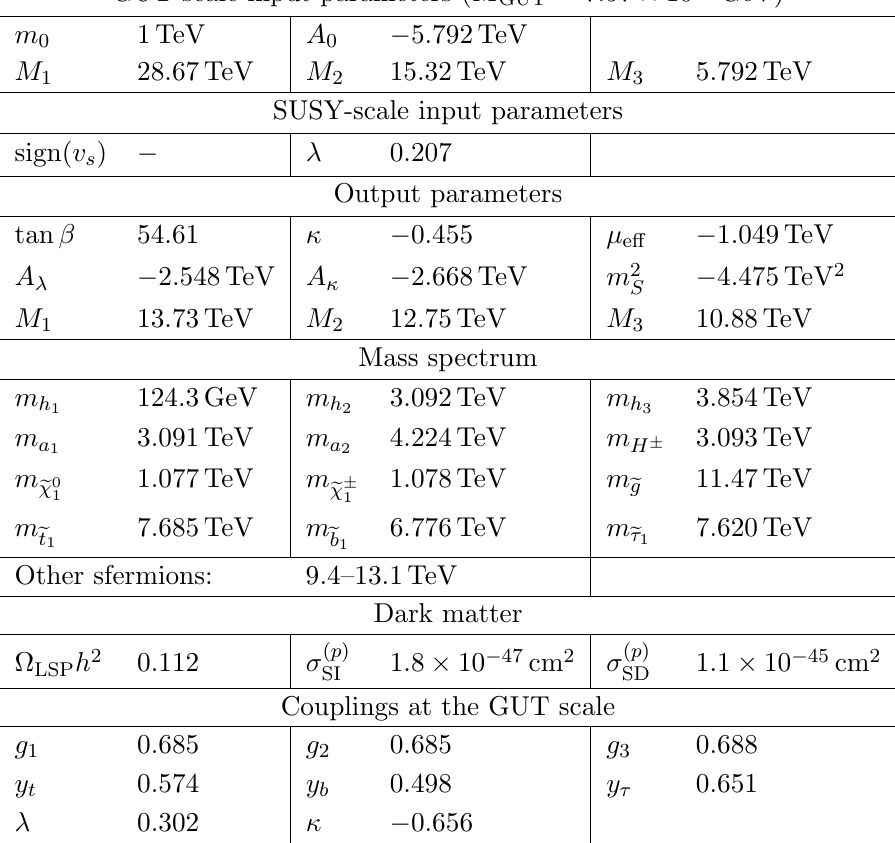
Table 1. Typical mass spectrum of the NMSSM with non-universal gaugino